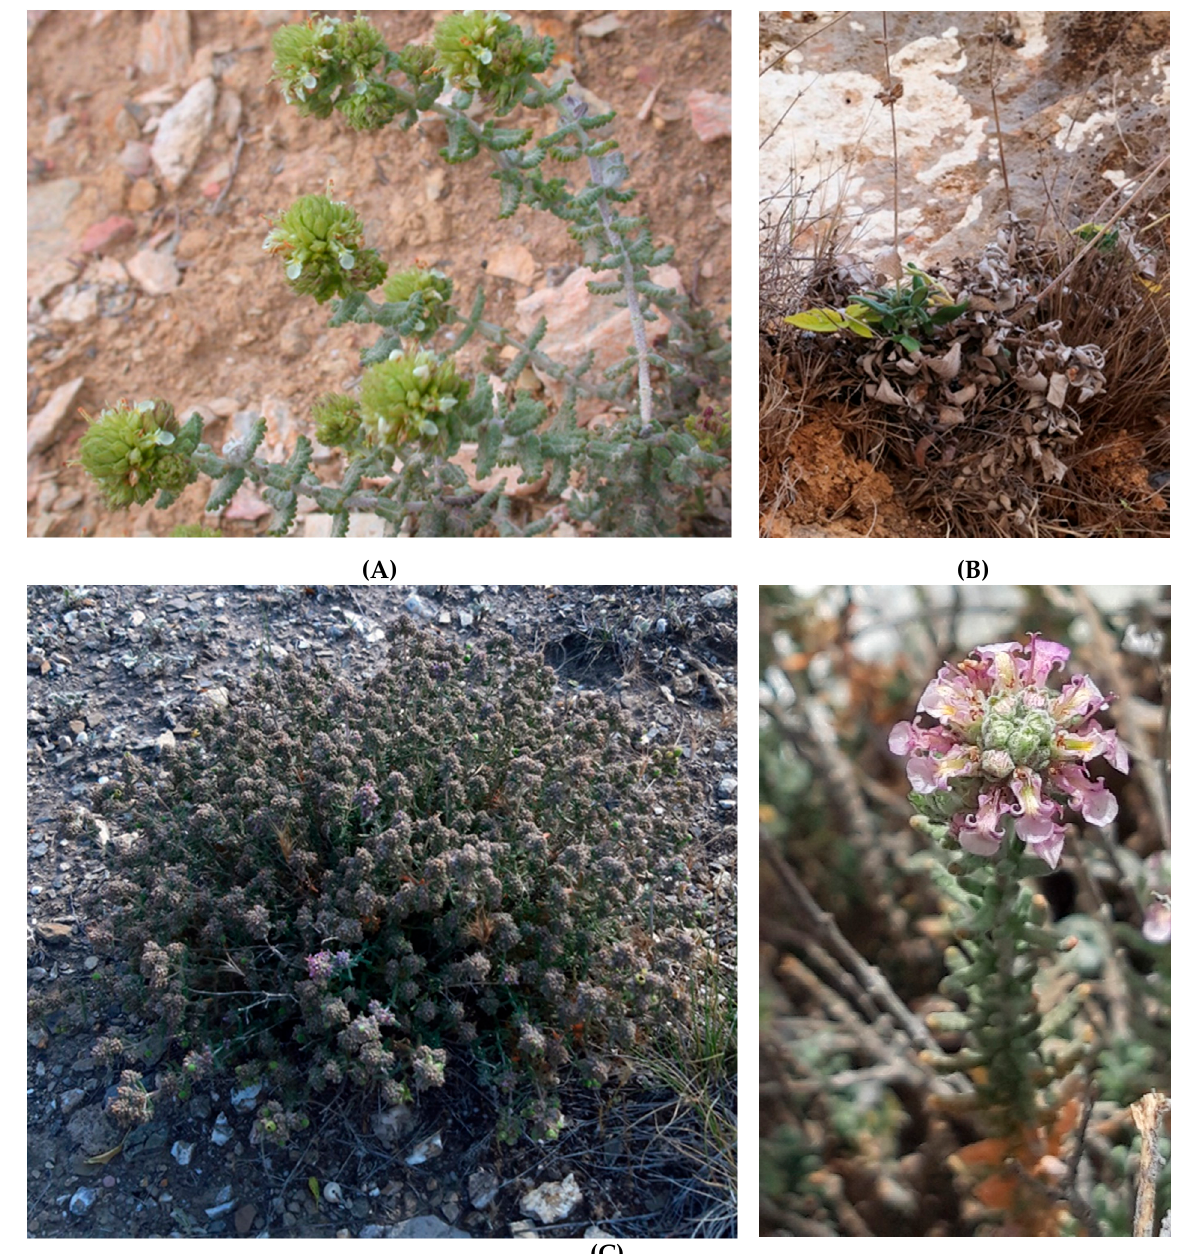
Figure 4. Top-evaluated endemic plants of Mediterranean coast and Rif of Morocco in terms of maximum possible score achieved regarding their agro-alimentary potential. ( A ): Teucrium huotii (Photo: M. Rouviere, http://www.ville-ge.ch/ musinfo/bd/cjb/africa/details.php?langue=fr&id=145076; accessed on 24 August 2021), ( B ): Salvia interrupta subsp. paui (Photo: A. Homrani Bakali, https://www.teline.fr/; accessed on 24 August 2021), ( C ): Teucrium gypsophilum (Left photo: F. Lamchouri; right photo: A. Khabbach). Propagation material has been collected from the wild for Teucrium gypsophilum to allow ex-situ conservation and propagation-cultivation trials at the Institute of Plant Breeding and Genetic Resources, Hellenic Agricultural Organization Demeter.